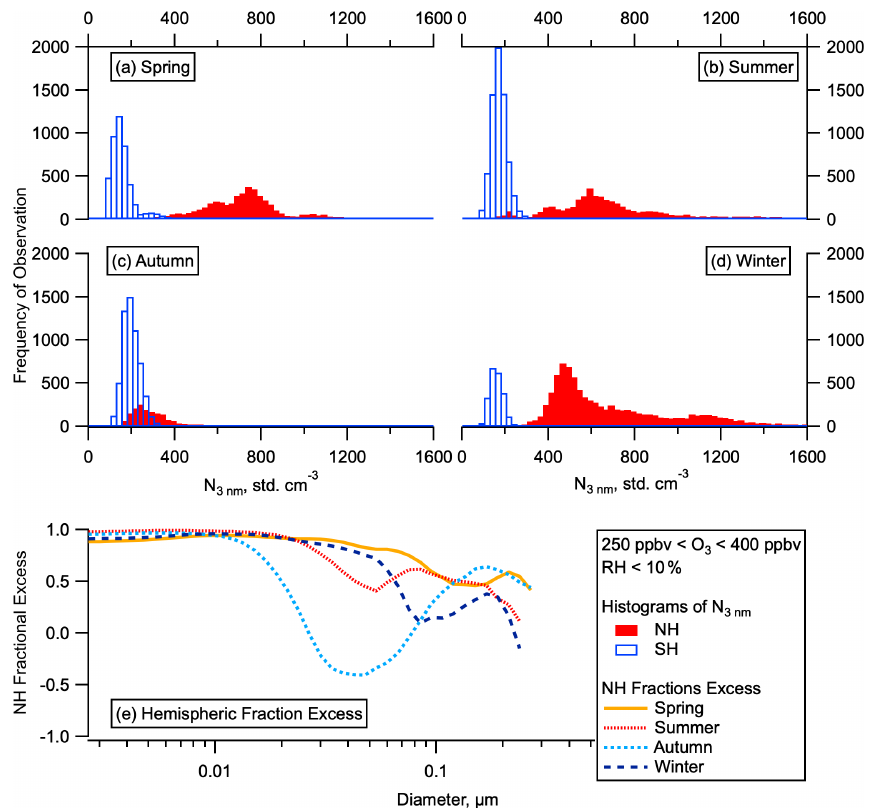
Figure 2. Hemispheric differences in particle number and concentrations. Histograms of the total number of aerosol between 3 and 4500nm in the LMS (ozone 250–400ppbv, altitude > 8km) for the SH and NH for all for ATom deployments (a–d) by season. Fractional excess of mean particle number in the NH compared to the SH (( N NH - N SH ) /N NH ) in each season as a function of particle diameter (e)